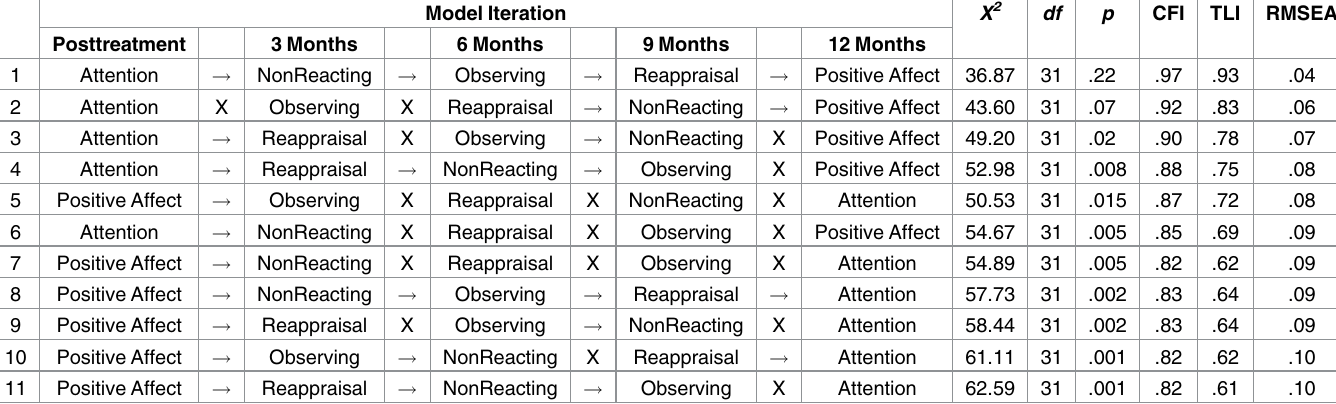
Table 2. Fit indices for final multivariate path model (Model 1) and alternative model